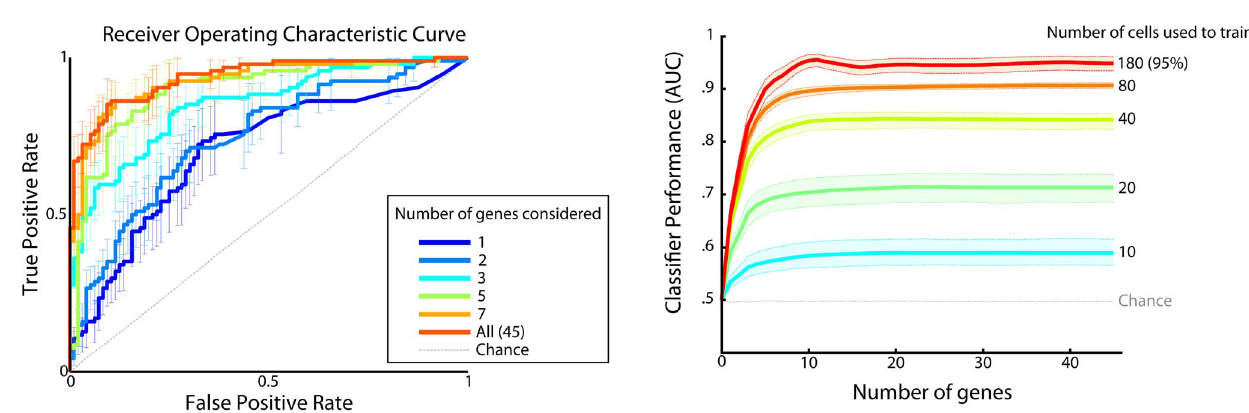
Figure 3. Discriminability of healthy versus cancer cells as a function of the number of genes considered. When measuring accuracy of cell classification as cancerous or healthy, one should consider both types of errors: false positives and false negatives (or more conventionally, true positives). This is illustrated by the Receiver Operating Characteristic (ROC) Curve. Lines indicate mean values, and error bars indicate bootstrapped 95% confidence intervals. Accuracy was measured using cross-validation; and chance value was determined using shuffle control.